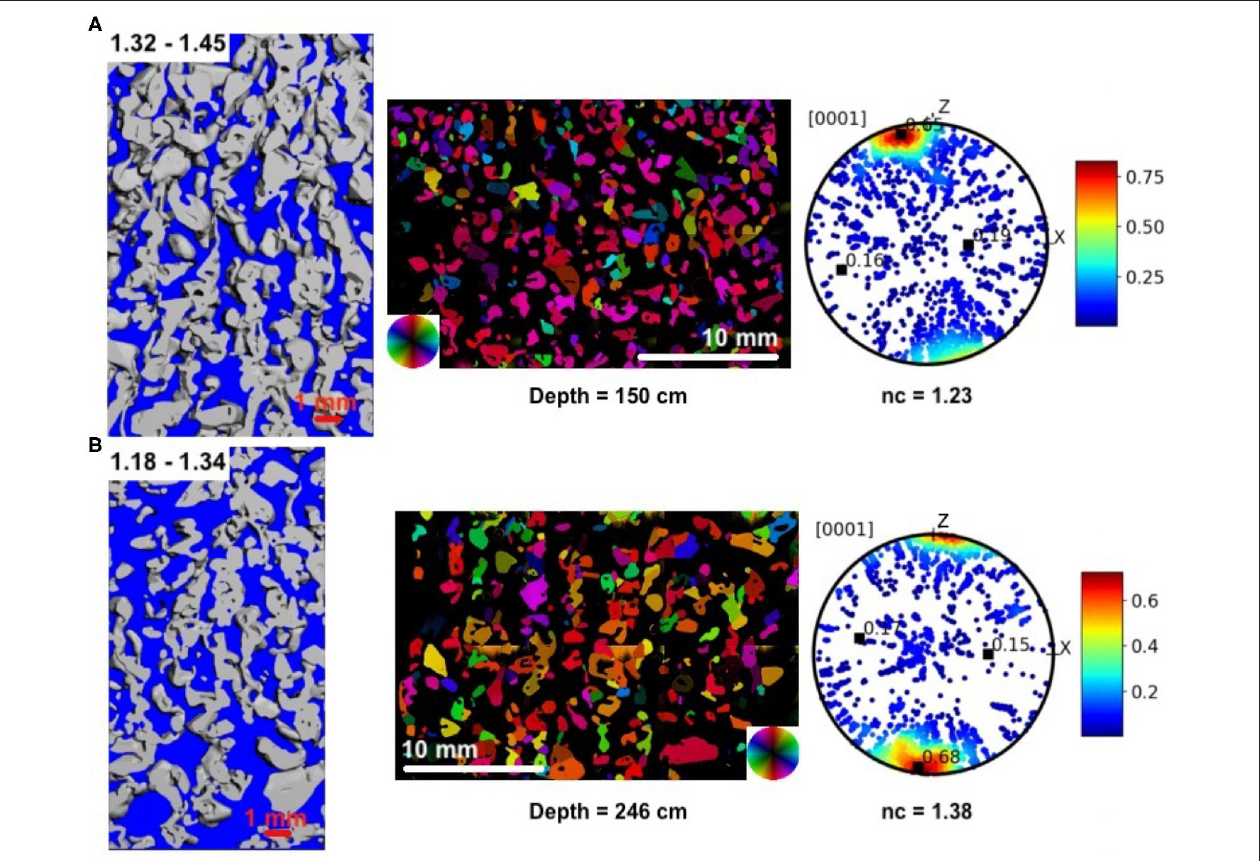
FIGURE 5 | MicroCT structure, microstructure and c -axis pole figure from samples extracted at 150 (A) and 246 (B) cm depth along the EastGRIP snow pit. The thin section was made in the microCT sample. A range of ǫ values is given in the microCT structure. The figures of microstructure are color-coded with the colorwheel that represents orientations of the c-axis. On the pole figures (right), randomly picked 5,000 pixels are plotted. The black squares correspond to the orientation of the eigenvectors of a (2) , and the associated eigenvalues are given. nc is the cluster index. The z-axis is the same for the three